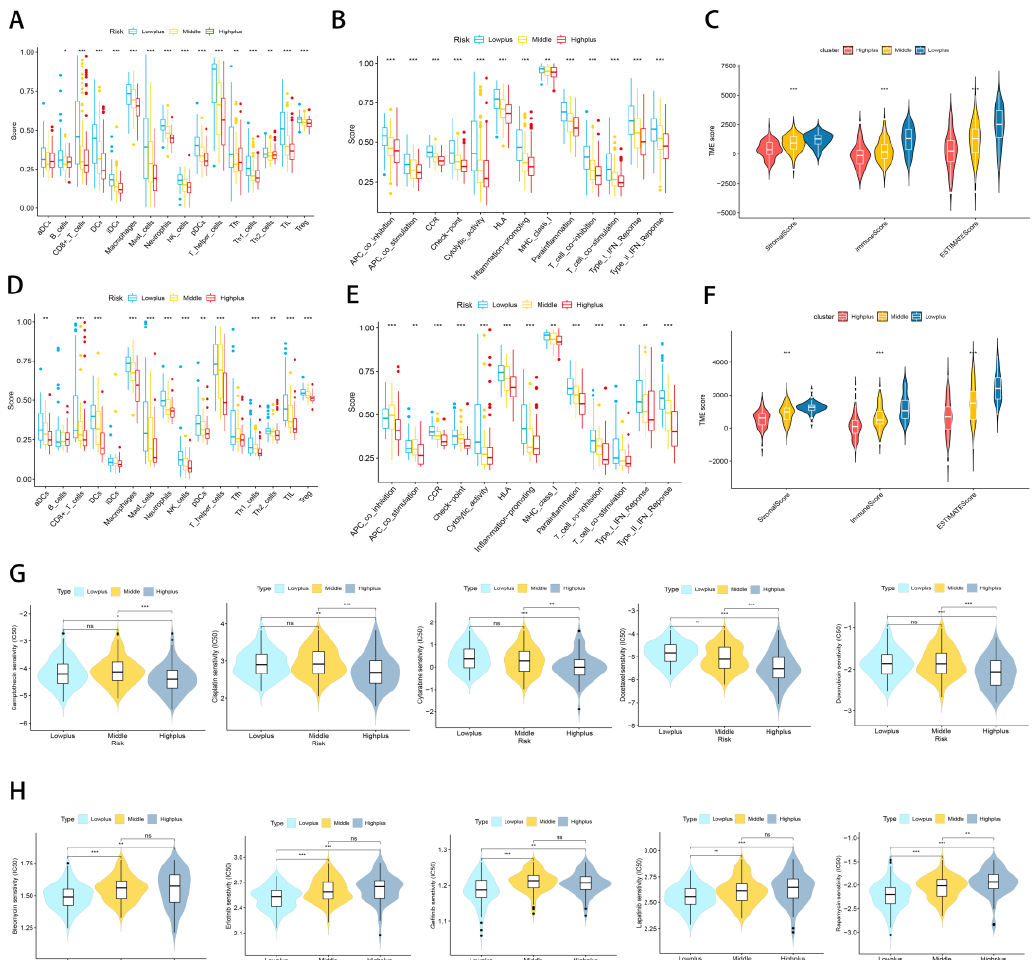
Figure 7. Subgroups of Hypoxia-TME display distinct immune responses and immune/chemotherapy sensitivity. ( A , D ) Comparative analysis of immune cells and immune functions in three different training risk groups. ( B , E ) Comparative analysis of immune cells and immune functions in three different testing risk groups ( C ) Analyze the immune status of each subgroup in the training set using ESTIMATE. ( F ) Analyze the immune status of each subgroup in the testing set using ESTIMATE. ( G ) Drugs that are highly effective for the Highplus group. ( H ) Drugs that are highly effective for the Lowplus group. ns, p ≥ 0.05; *, 0.01 ≤ p < 0.05; **, 0.001 ≤ p < 0.01; ***, 0.0001 ≤ p < 0.001.